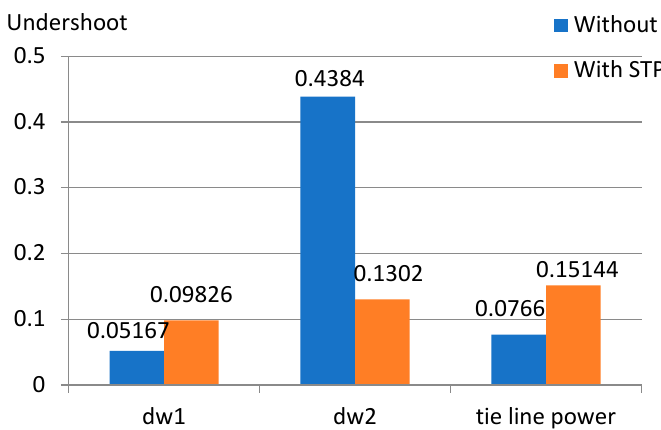
Figure 17. Variations of settling time with step load perturbation.